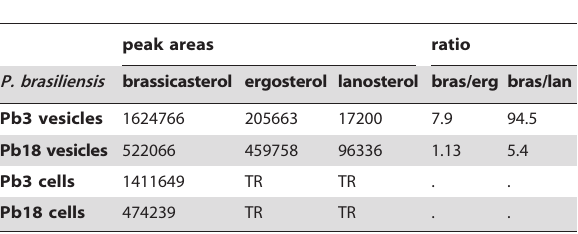
Table 2. Composition of Pb3 and Pb18 extracellular vesicle and whole yeast cell total sterols identified by GC-MS. TR, trace amounts.